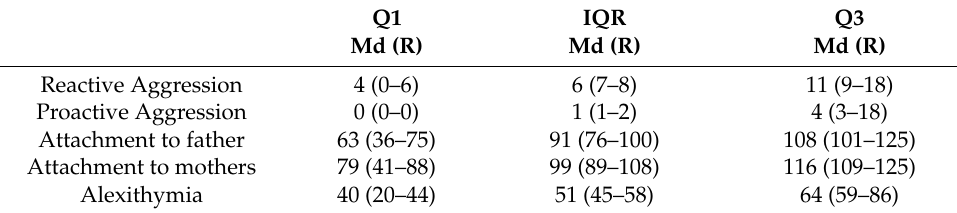
Table 2. Variables’ median and values range within each quartile.